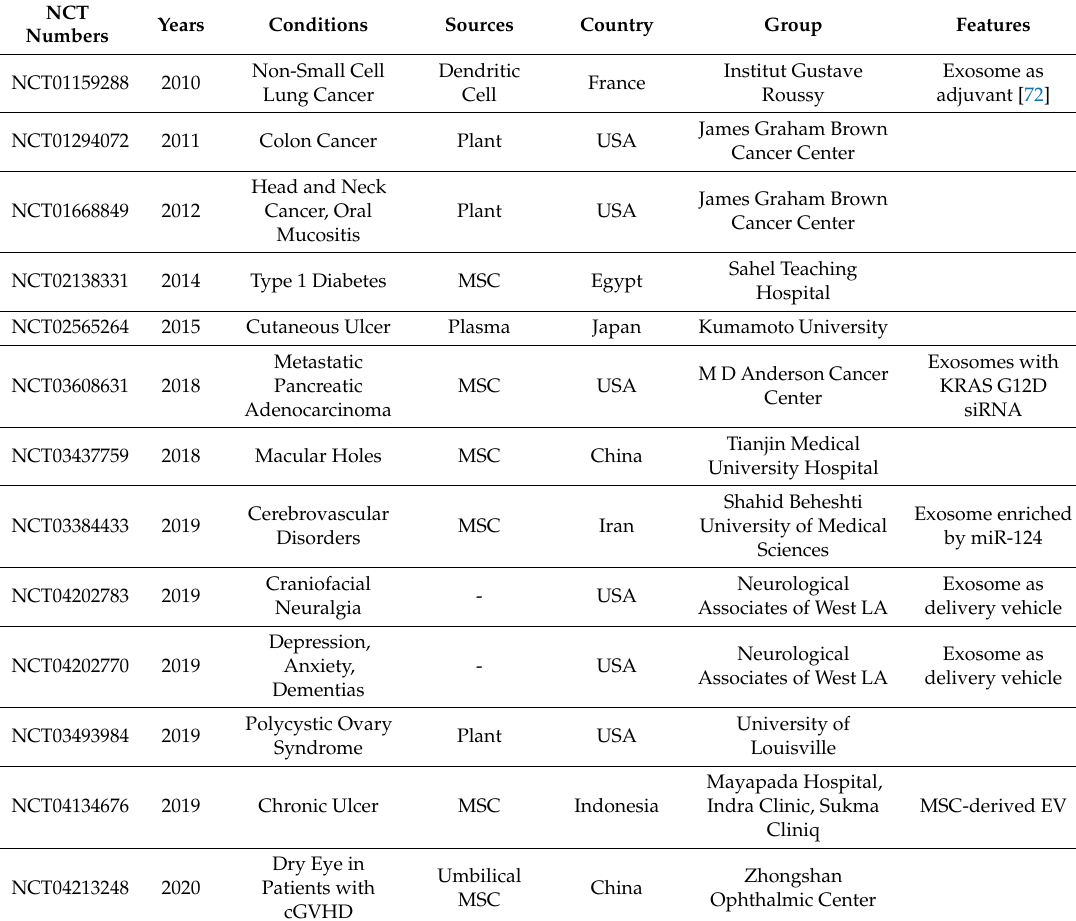
Table 2. Current clinical trials of exosomes. cGVHD: choronic Graft versus Host